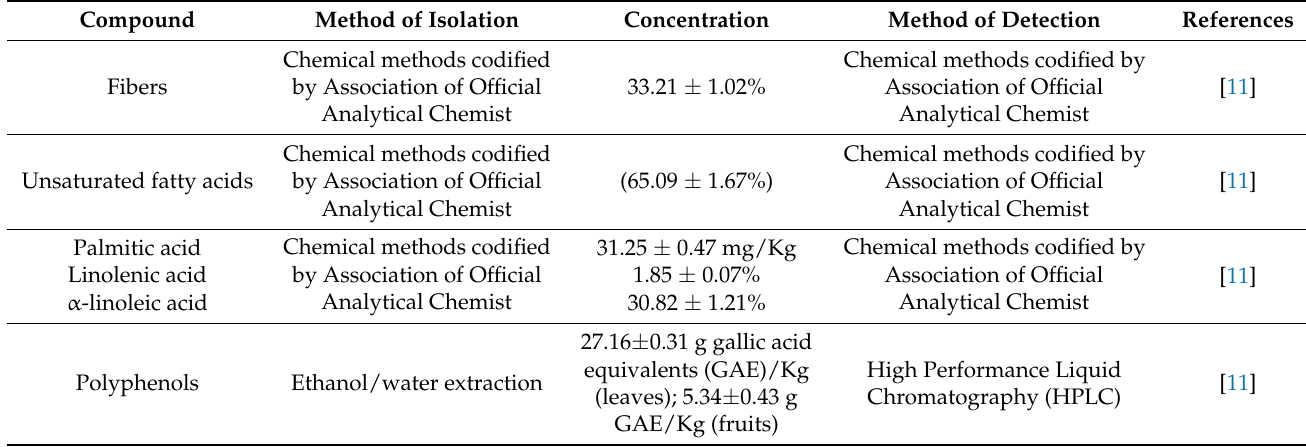
Figure 1. Phytochemicals present in Sumac shrub [1,2,6,8,11,14,15]. Table 1. Bioactive compounds of Sumac plants, according to extraction Table 2. Composition of Sumac components based on extraction solvent.